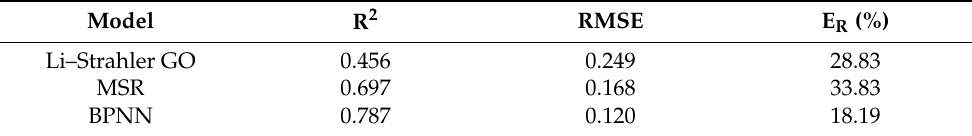
Table 18. The estimation accuracy of comparative experiments.